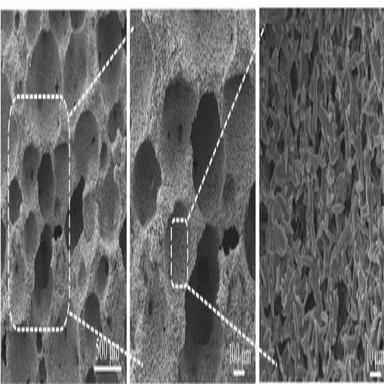
Microstructures of lightweight porous materials with varying AlF3⋅3H2O contents. (a) 0, (b) 3, (c) 6, and (d) and 9 wt%.